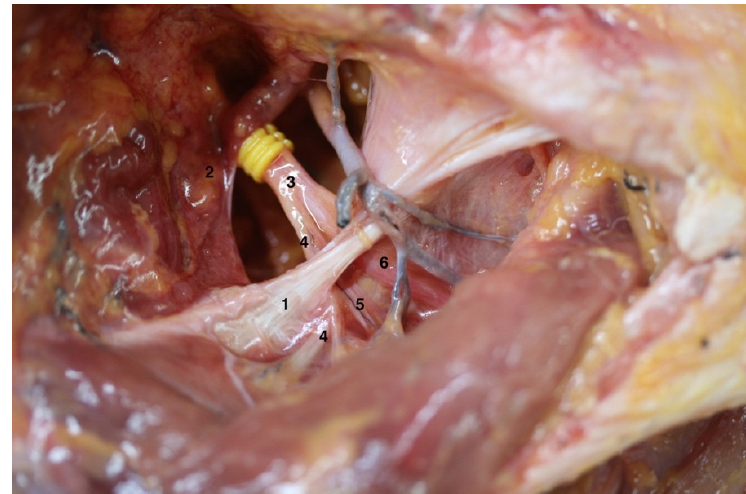
Figure 2. Anatomical variation on the right shoulder from specimen F: the different anatomical structures could be observed as follows: (1) Superior transverse scapular ligament; (2) Inferior belly of the omohyoid muscle; (3) Suprascapular nerve; (4) Acromioclavicular sensitive branch; (5) Supraspinatus motor branch; (6) Infraspinatus motor branch; note that the division into the supraspinatus and infraspinatus motor branches is proximal to superior transverse scapular ligament.